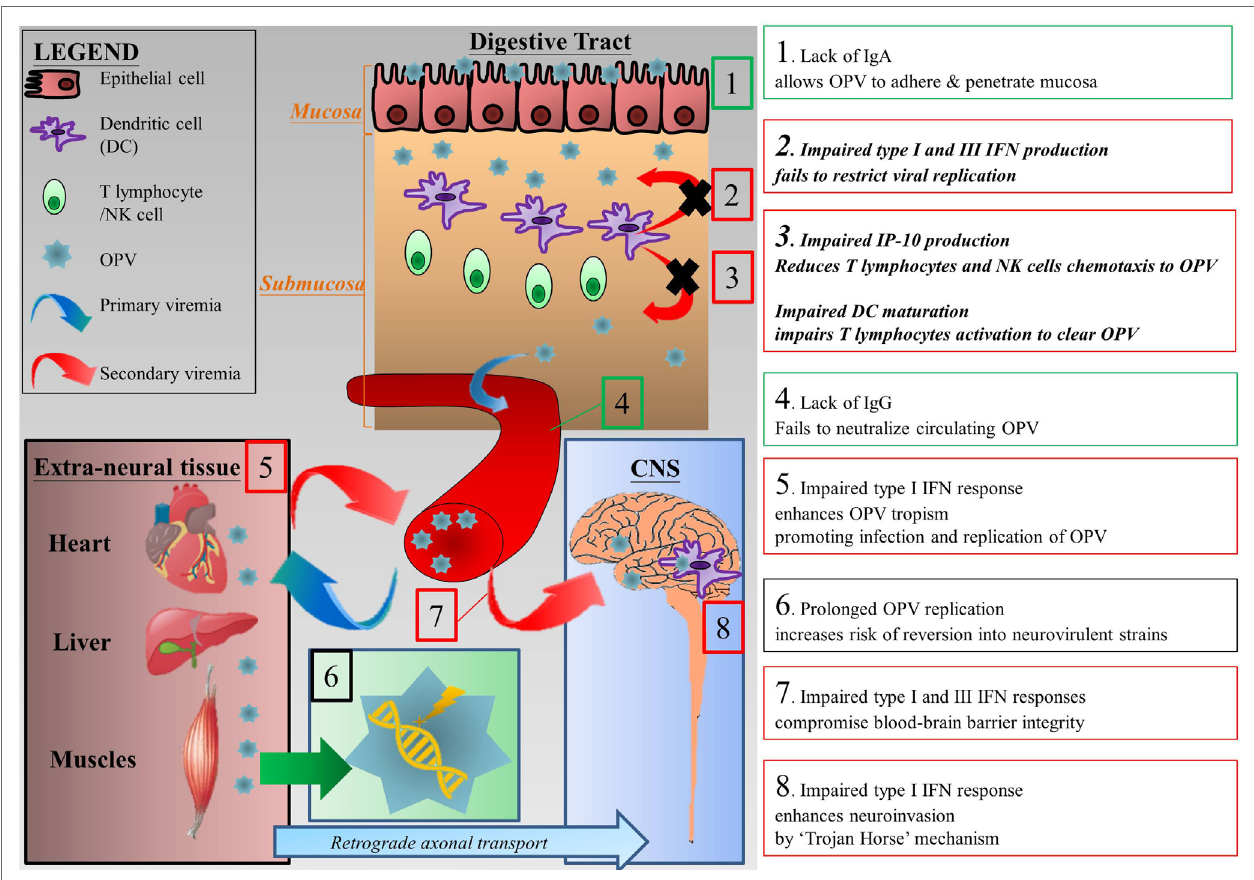
FigUre 8 | Postulated mechanisms that increase the risk of vaccine-associated paralytic poliomyelitis in XLA patients. (1) Lack of secretory Ig A allows OPV to adhere and penetrate digestive tract mucosa (78). (2) At the mucosa, restriction of viral replication is impaired due to impaired type I and III IFN productions (14, 15). (3) In addition, impaired IP-10 production and phenotypic maturation of dendritic cells reduce T lymphocytes migration and activation which in turns impair clearance of OPV infection (42, 43). (4) The lack of neutralizing antibodies in XLA patients results in prolonged viremia. (5) The lack of type I IFN enhances tropism of OPV, allowing more extensive infection of extraneural tissues by OPV and thus enhancing replication of OPV, which leads to sustained secondary viremia (74, 80). (6) Prolonged replication of OPV increases the chance of mutation which may revert the vaccine strain to a neurovirulent one (5, 6, 73, 81). (7) Type III IFN protects the epithelium component of blood–brain barrier, while type I IFN protects the endothelium component. Combined impairment of both type I and III IFN compromises blood–brain barrier integrity (82). (8) Finally, OPV can enter central nervous system (CNS) via “Trojan horse” mechanism in which they cross the blood–brain barrier by hiding in immune cells such as macrophages. Type I IFN response may limit CNS invasion by “Trojan horse” mechanism (82). Green textboxes represent humoral immunodeficiency and its consequences in XLA patients and red textboxes represent innate immunodeficiencies and their consequences in XLA patients. Textboxes with italic and bolded text represent our findings and their consequences. Abbreviations: CNS, central nervous system; IFN, interferon; IP-10, interferon gamma- induced protein 10; OPV, oral polio